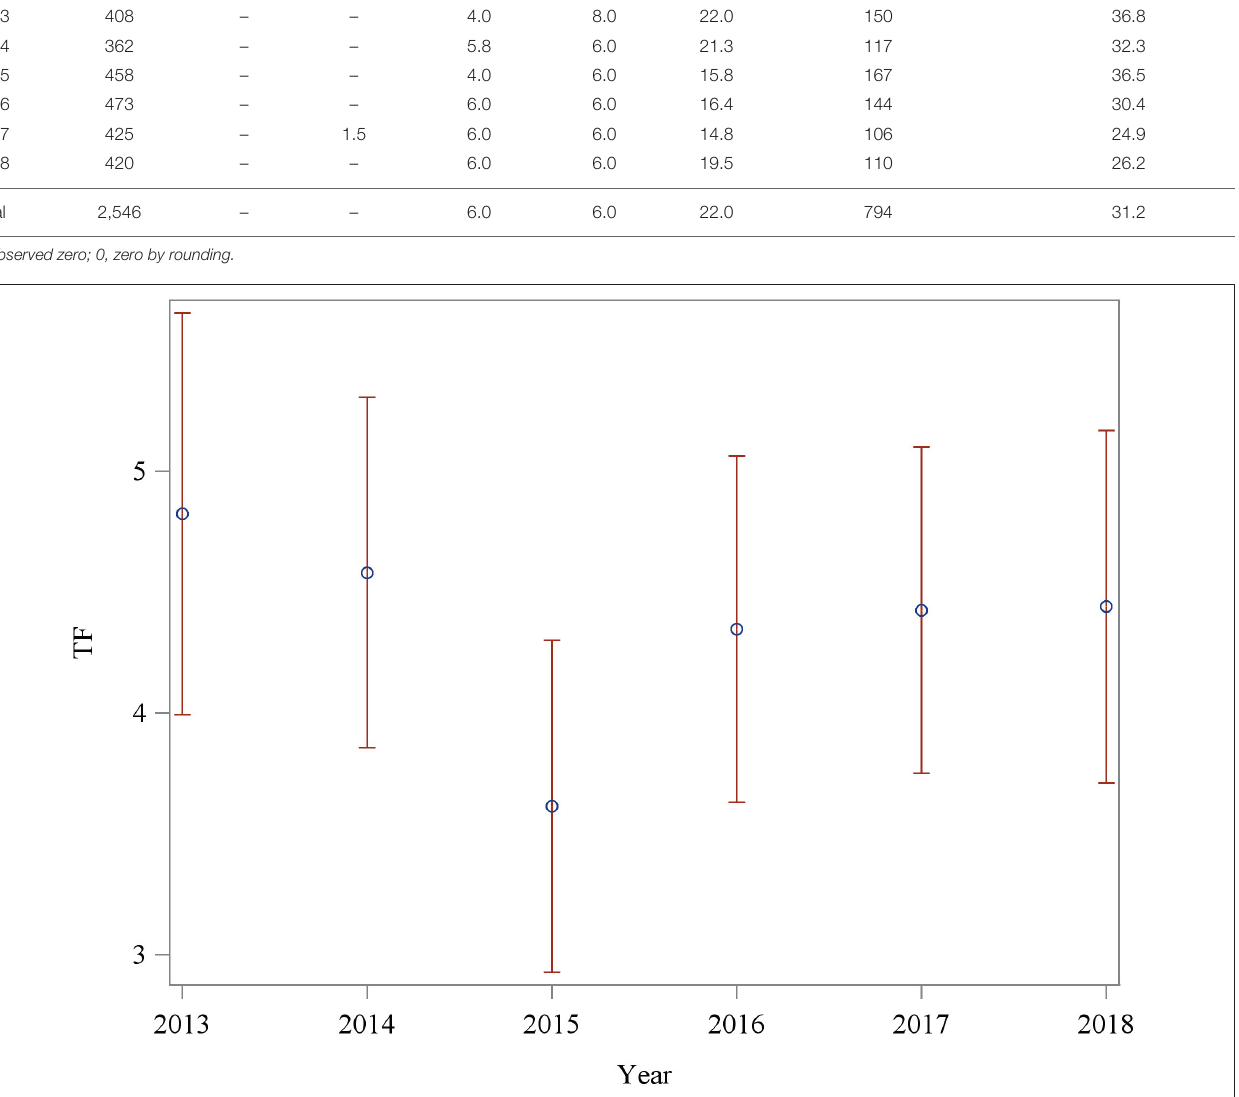
treatment duration over the complete study period was 3 days, ranging from 1 to 5 days.